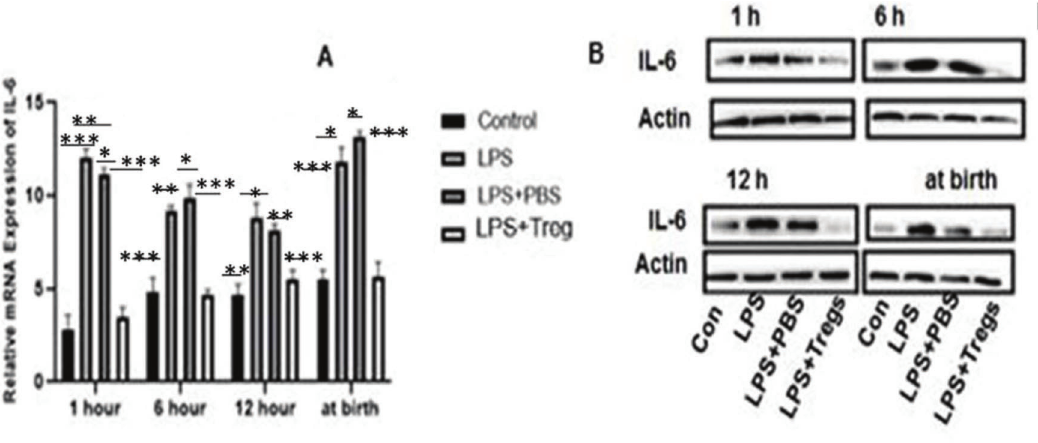
Figure 2 - Expression of IL-6 in fetal liver tissues after maternal LPS administration. (A) The mRNA expression of IL-6 was significantly increased at the four indicated time points in the LPS + PBS group versus LPS group, compared to the levels in the PBS group. Adoptive transfer of Tregs markedly inhibited the LPS-induced upregulation of IL-6 mRNA expression ( p o 0.05, * p o 0.05, ** p o 0.01, and *** p o 0.001). (B) The western blotting results showed that the protein expression of IL-6 in the groups followed a trend similar to that of the IL-6 mRNA